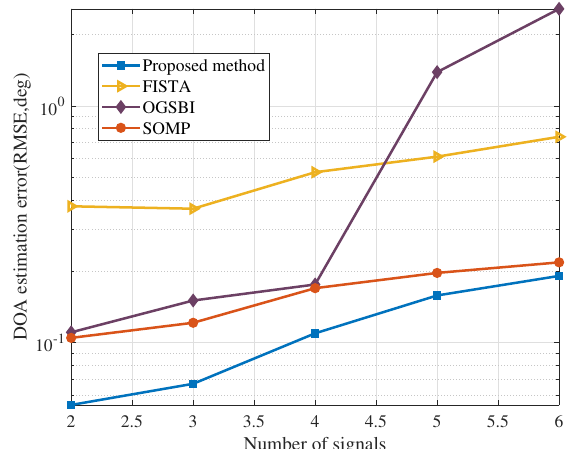
Figure 6. DOA estimation performance with different numbers of targets.